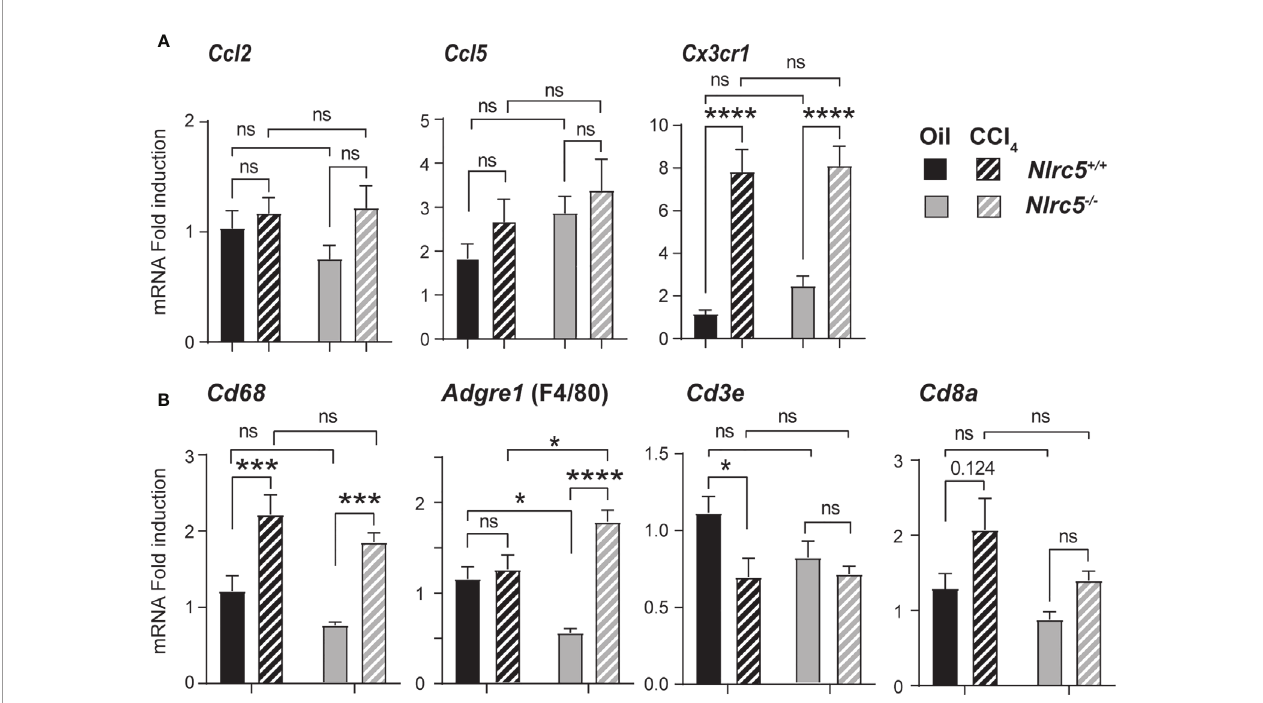
FIGURE 6 | Increased expression of F4/80 gene in the fi brotic livers of NLRC5-de fi cient mice. RNA extracted from liver tissues from the indicated groups of mice were evaluated for the gene expression of (A) chemokines ( Ccl2, Ccl5, Cx3cr1 ) and (B) the markers of macrophages (CD68, F4/80) and T lymphocytes (CD3 ϵ , CD8 a ). Data shown are mean ± SEM; n= 7-11 mice for each group from 2-3 independent experiments. Two-way ANOVA with Tukey ’ s post-hoc test: *p < 0.05; ***p < 0.001; ****p < 0.0001; ns, not signi fi cant. For certain comparisons, signi fi cance values are